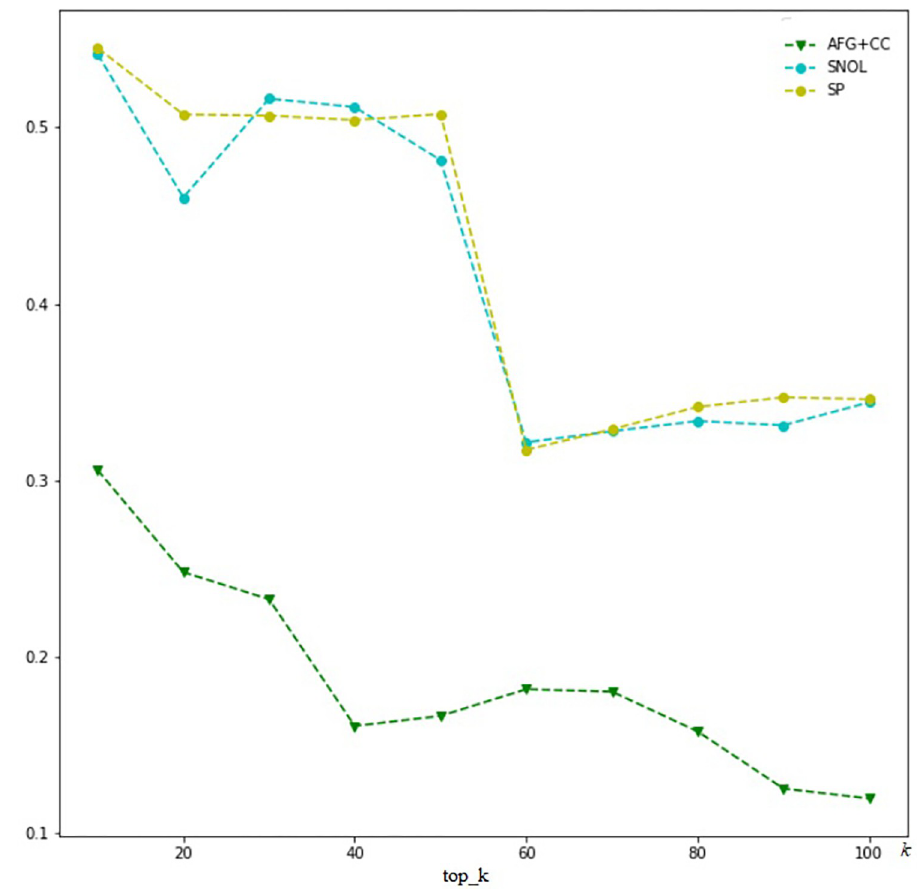
Fig 4. Similarity scores of AFG + CC, SNOL and SP